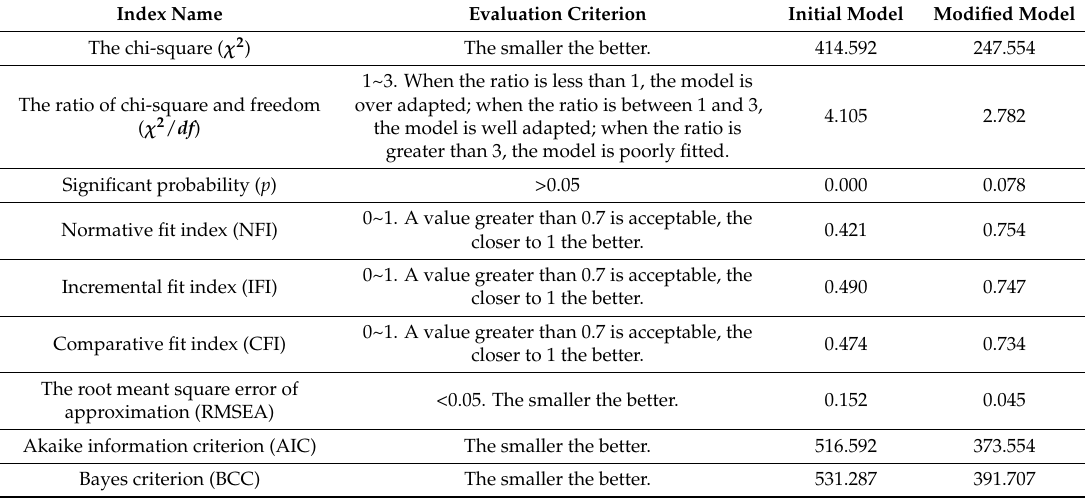
Table 3. The fitting parameters describing the coupling relationship between stand structure and soil properties of artificial mixed forests in the Caijiachuan